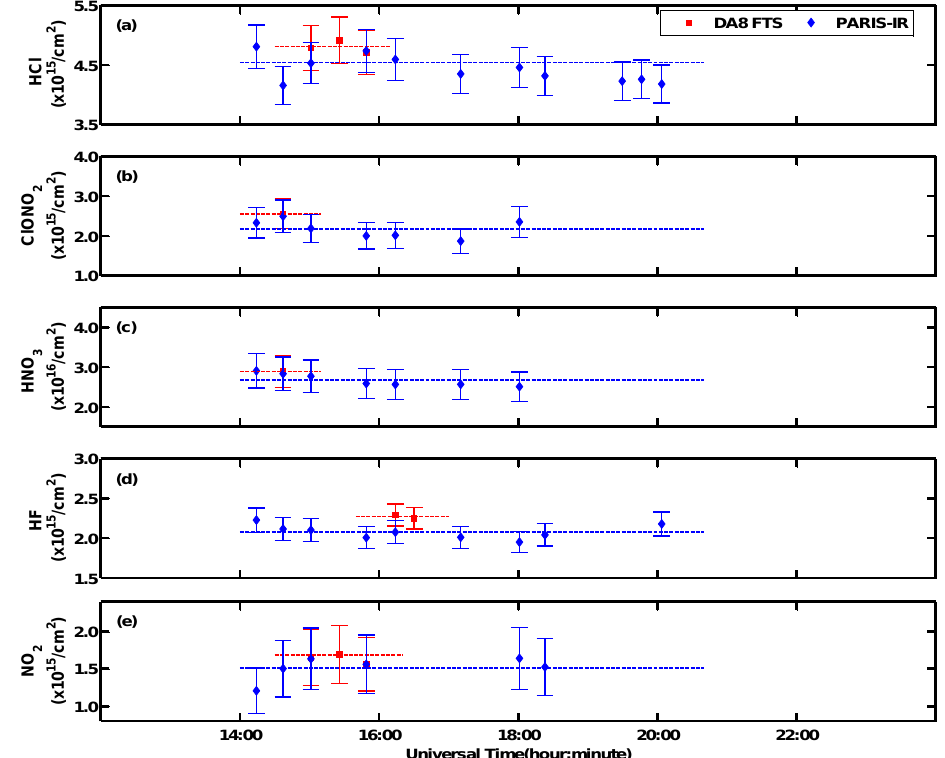
Fig. 5. Same as Fig. 4 but for 7 March